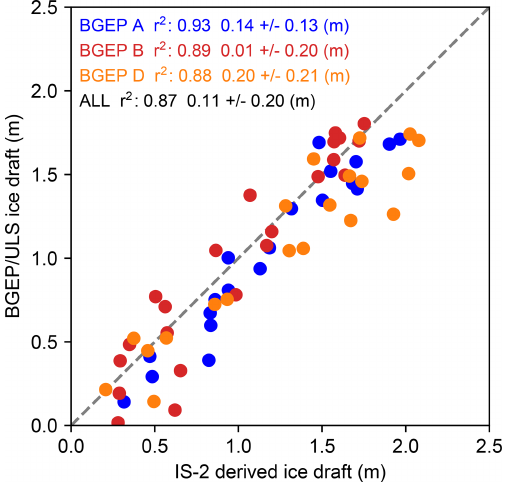
Figure 10. Comparisons of IS2SITMOGR4, v2 (November 2018– 2021), converted to ice draft against ice draft measurements ob- tained by Beaufort Gyre Exploration Project (BGEP) upward- looking sonar moorings. The mean of all IS2SITMOGR4 data within 50km of the given mooring is used in this